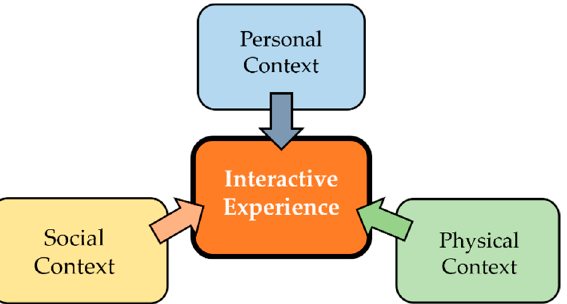
Figure 2. The interactive experience model (IEM) (source: adapted from Falk and Dierking [21]).